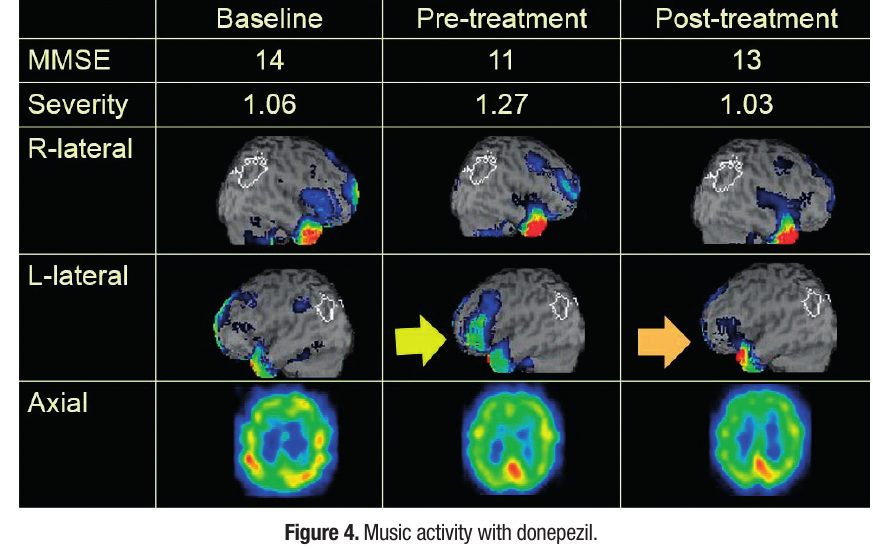
Figure 4. Music activity with donepezil.